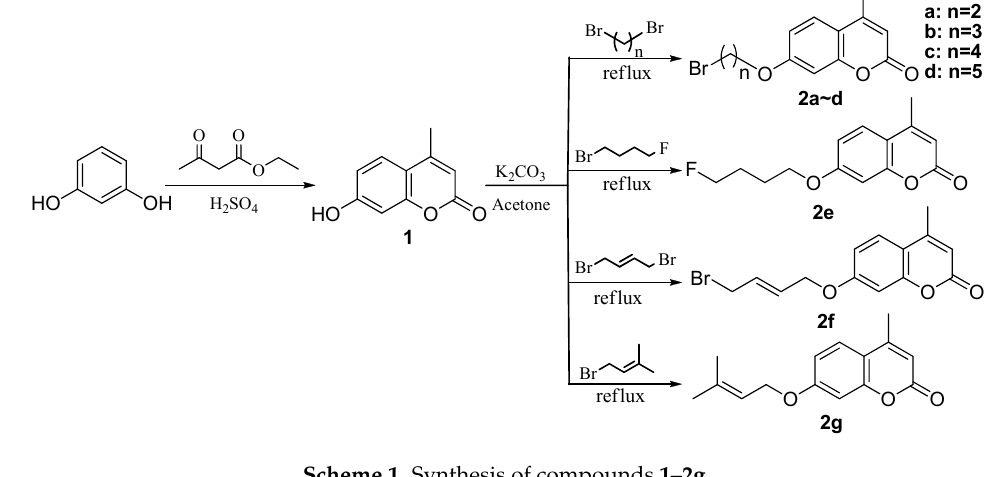
Scheme 1. Synthesis of compounds 1 – 2g .